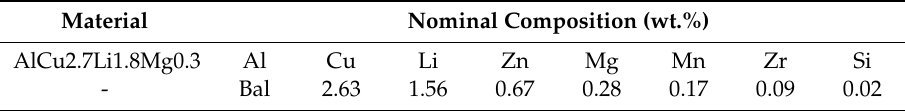
Table 1. Nominal composition (wt.%) of gas-atomized AlCu2.7Li1.8Mg0.3 powder. Material Nominal Composition